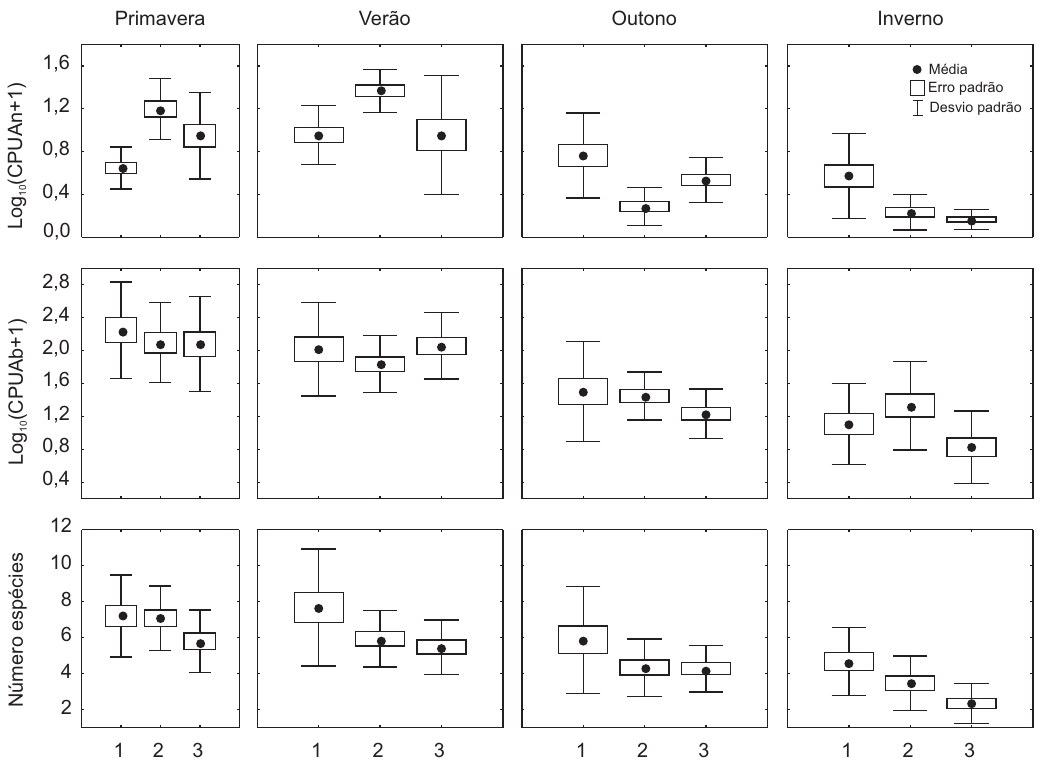
Figura 4. Variação espaço/temporal da CPUAn, CPUAb e número de espécies mostrados em função dos locais de coleta 1, 2 e 3.